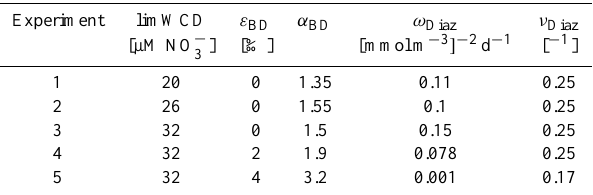
Table 1. Model experiment parameter settings. Parameters are the nitrate threshold for the limitation of WCD (limWCD), BD frac- tionation ( ε BD ), scaling factor for BD rate ( α BD ), prey-capture rate for zooplankton grazing on diazotrophs ( ω Diaz ), and mortality of diazotrophs ( ν Diaz